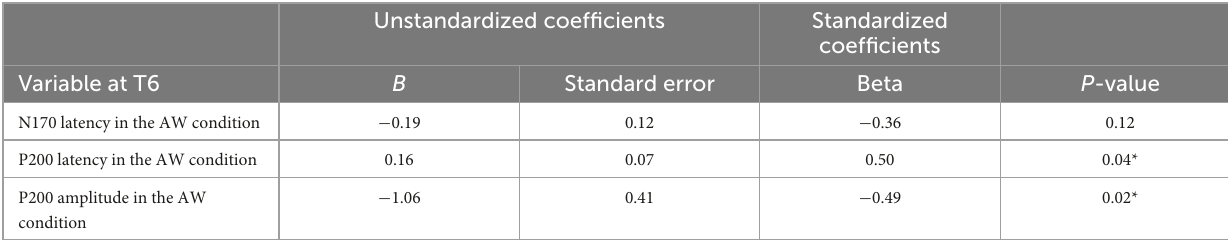
TABLE 2 Multiple regression analysis table of the model with the smallest CVE at the T6